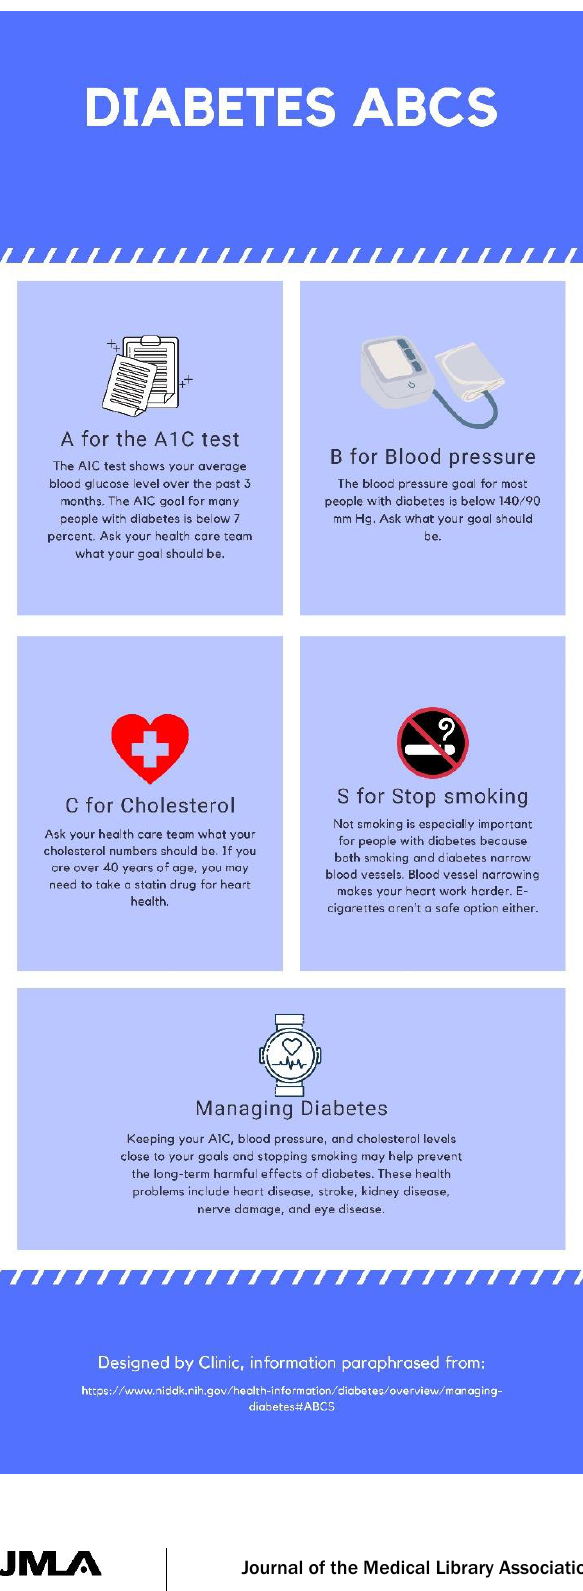
Figure 1 The infographic we created as an example of a design during the third webinar. This was not intended for use with farmworkers but as an example of the layout and design functions within